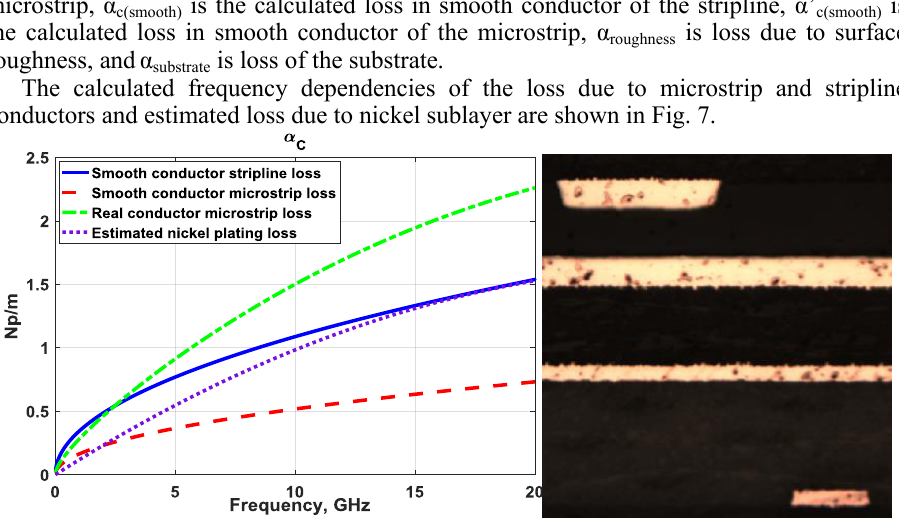
Fig. 7. Calculated microstrip and stripline conductor losses and extracted loss due to nickel